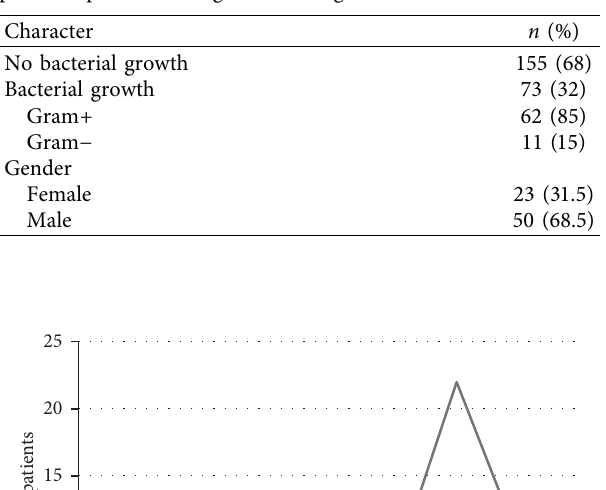
Table 2: Prevalence of Gram-positive bacteria isolated from ocular specimens.